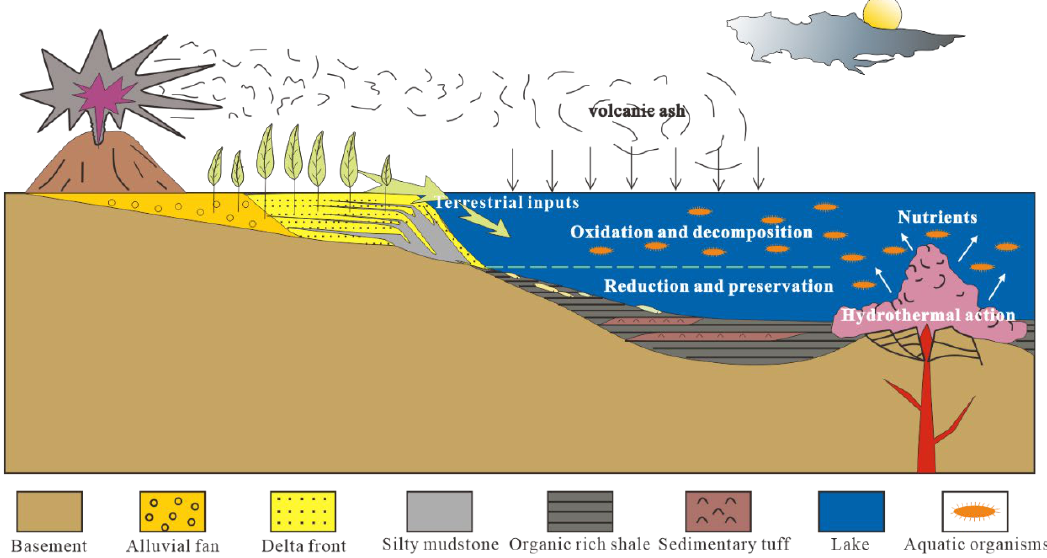
Figure 9. Enrichment model of OM in Chang 7 shale of the southern margin of Ordos Basin.